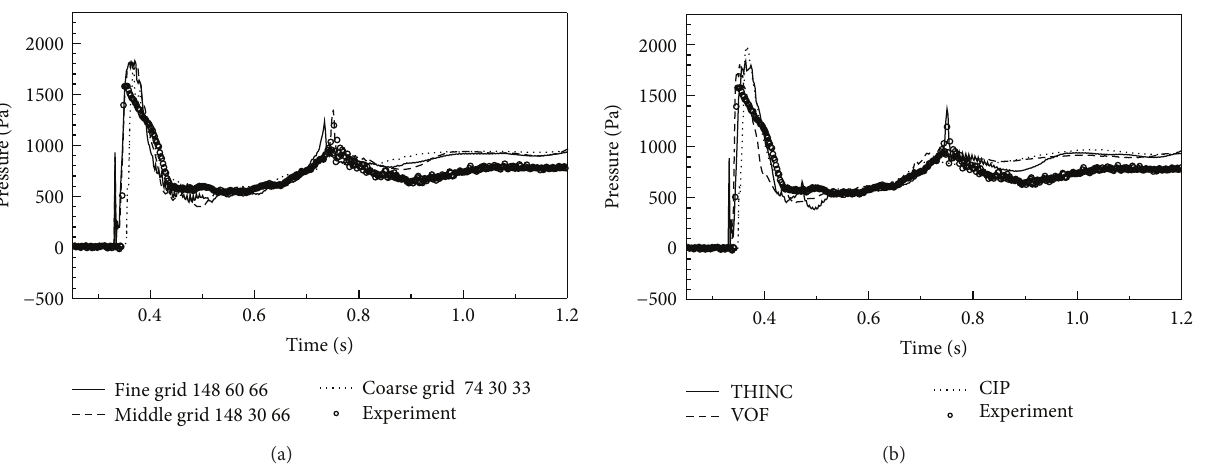
Figure 6: Impact pressure (3D) using different grid sizes (a) and using different free surface capturing methods (b). water elevation and green water impact pressure with the experimental results. A set-up overview of this problem is illustrated in Figure